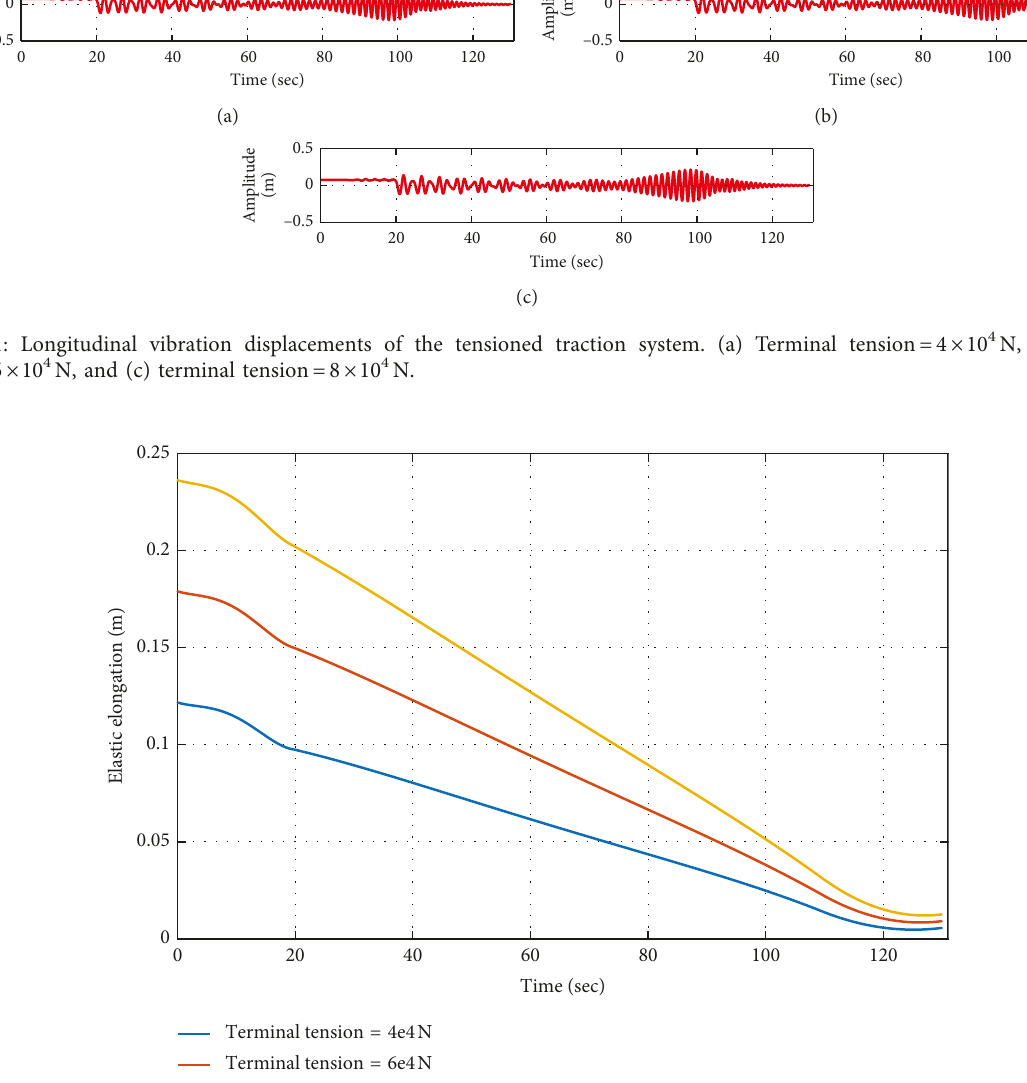
4 10 4 N, (b) terminal (cid:31) ×